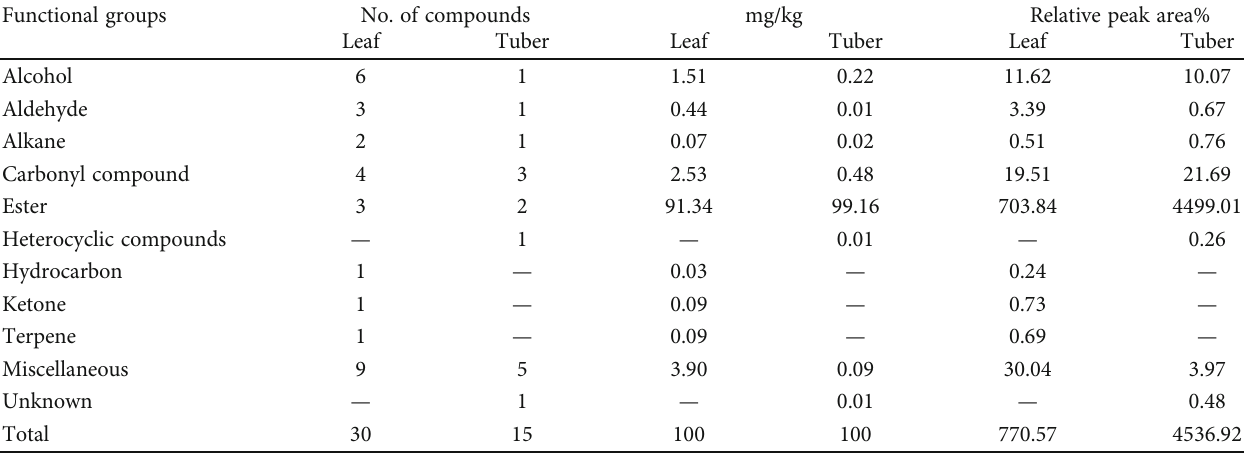
Table 4: Content of functional groups in identi fi ed volatile components from anchote leaves and tubers. Functional